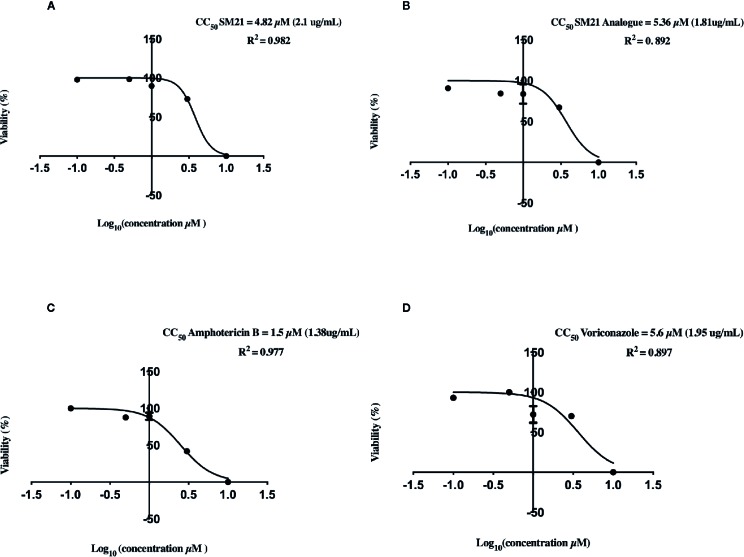
Cytotoxicity of each drug on HK-2 cells determined by quantitative CellTiter-Glo® of ATP Luminescent Cell Viability Assay. CC50 of Logarithm curves (A) SM21, (B) SM21 Analogue, (C) Amphotericin B, and (D) Voriconazole. The graphs were plotted based on logarithm of drug dosage and the CC50 was calculated by probit regression method using Prism 8. SM21 and its analogue showed lesser cytotoxicity and potency to induce proximal tubular damage in HK-2 compared to AmB (4.82, 5.36, and 1.5 μM; respectively). HK-2, immortalized human kidney proximal tubule epithelial cells.